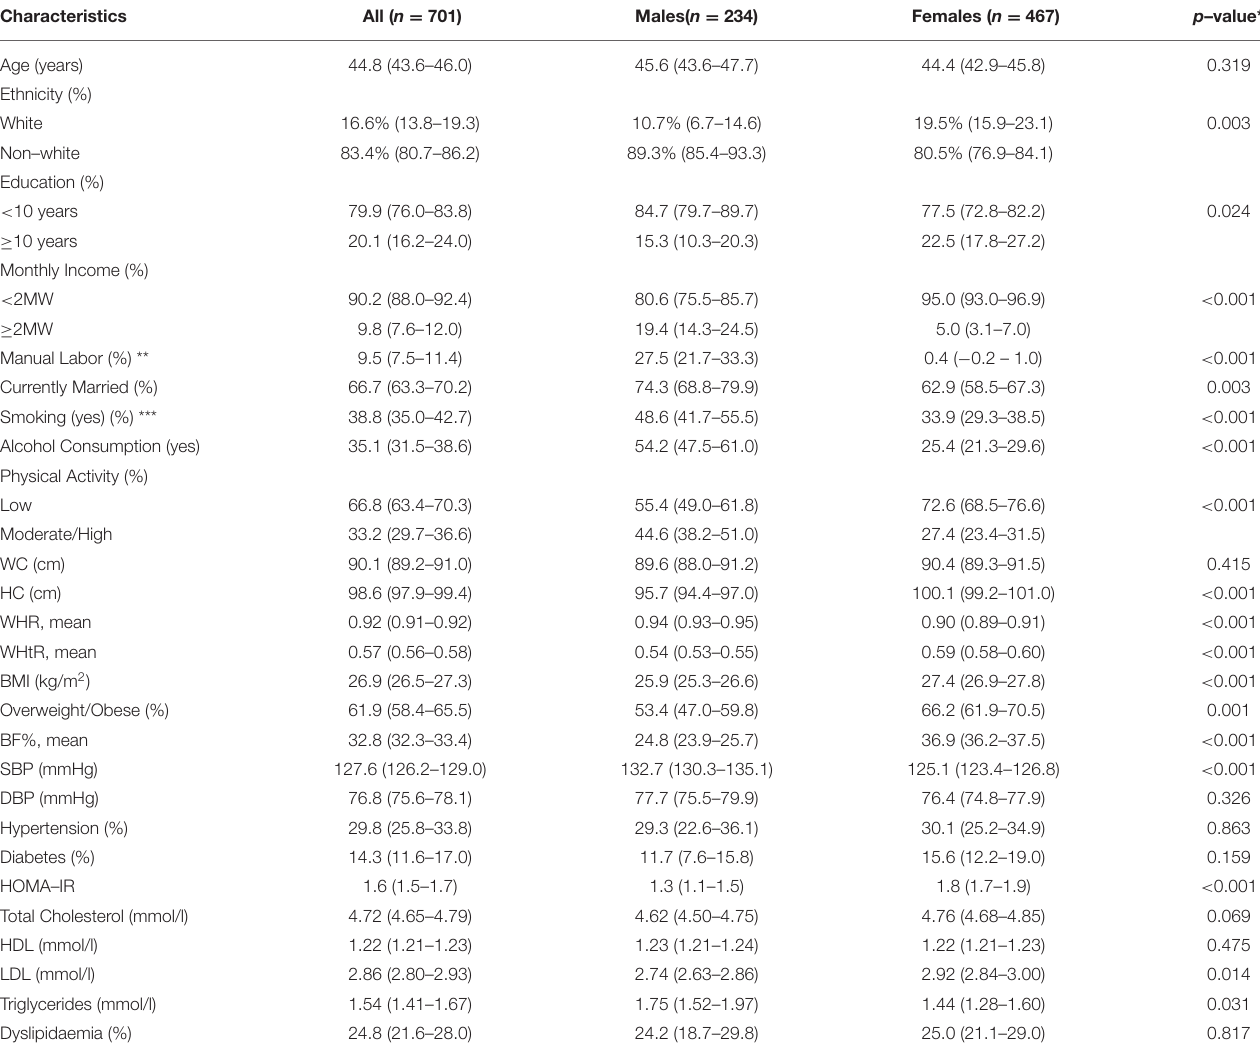
TABLE 1 | Baseline characteristics of the study subjects.